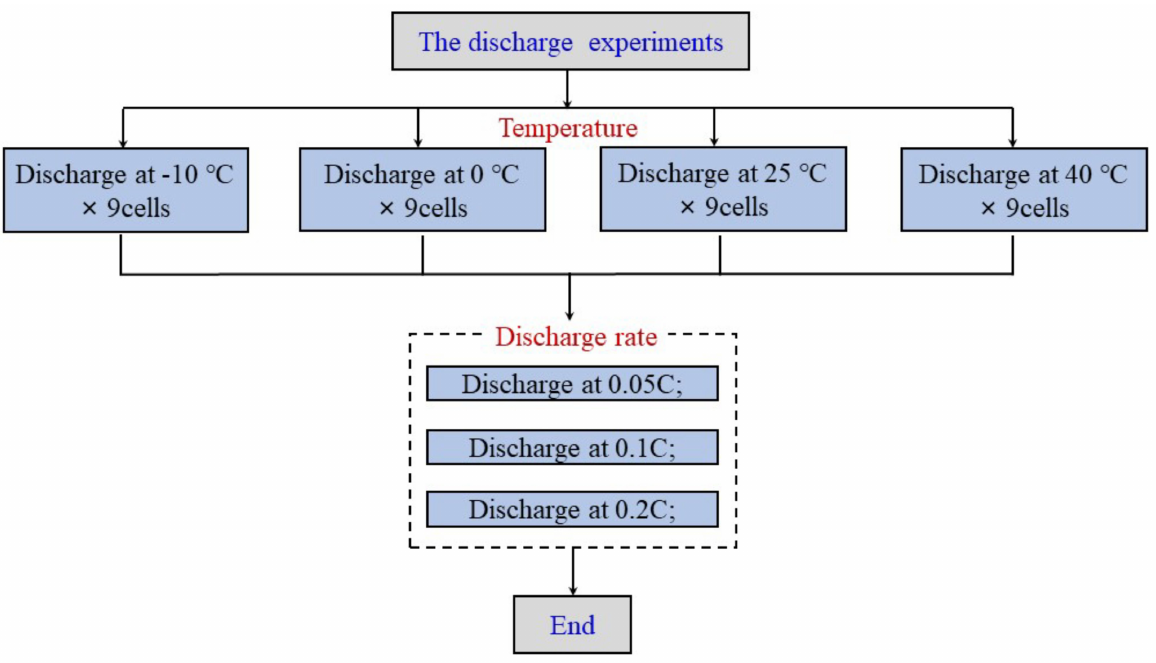
Figure 3. The flow chart of the discharge